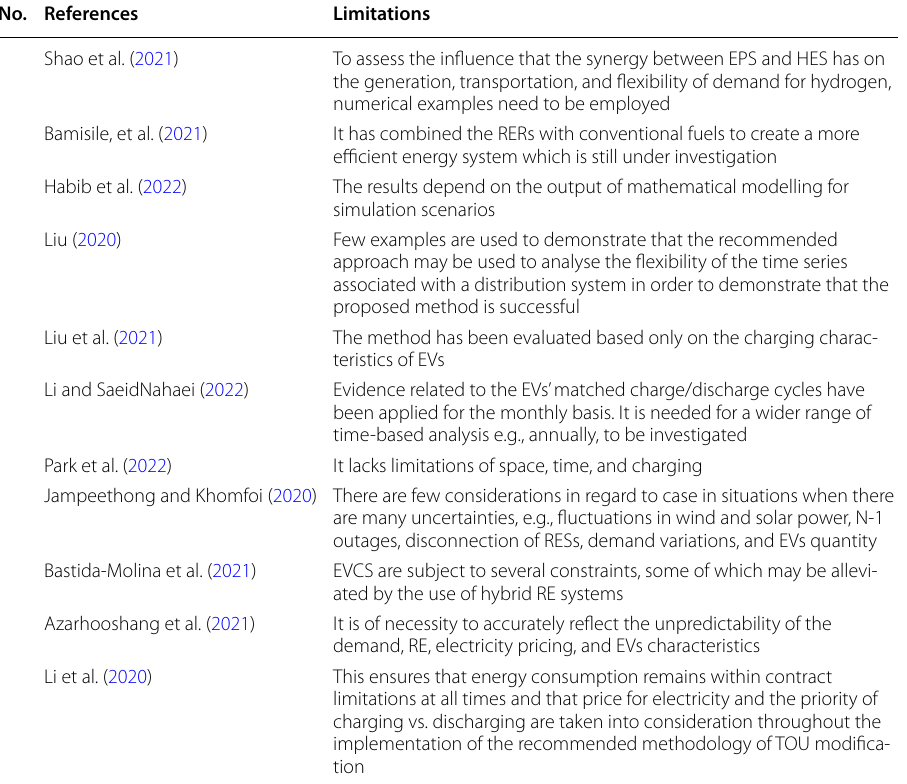
Table 4 A listed set of limitations of the reviewed papers No.